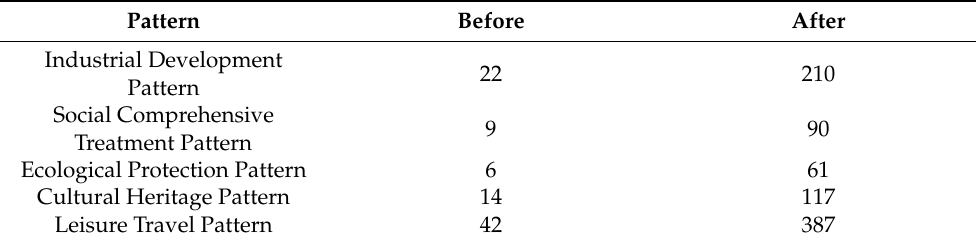
Table 5. Changes in data scale before and after data argumentation. Pattern